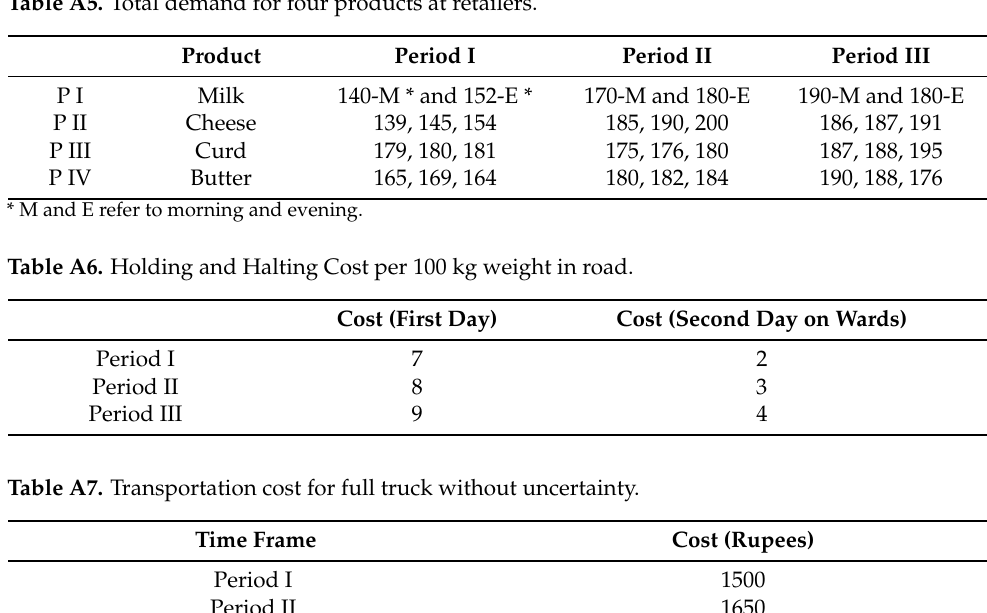
Table A5. Total demand for four products at retailers.